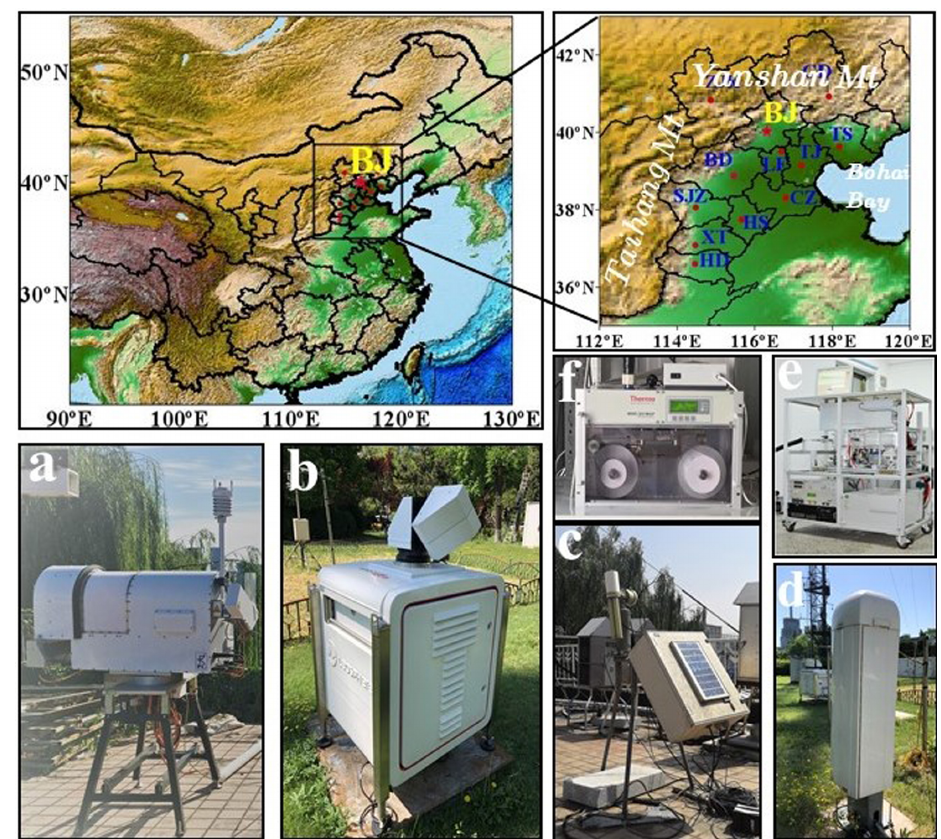
Figure 1. The geographical location of Beijing city (BJ) marked with a red star as well as surrounding regions and relevant measurement instruments implemented in this paper. The top-left panel is the topographic distribution of most of China with Beijing and surrounding areas marked, and the top-right panel is the topographic distribution of the Beijing–Tianjin–Hebei (BTH) region, with the Yan Mountains to the north, the Taihang Mountains to the west and Bohai Bay to the east. The blue letters are abbreviations of city names in the BTH region ( a : microwave radiometer; b : 3D Doppler wind lidar; c : CIMEL sun photometer; d : ceilometer; e : Aerodyne aerosol chemical speciation monitor (ACSM); f : multiangle absorption